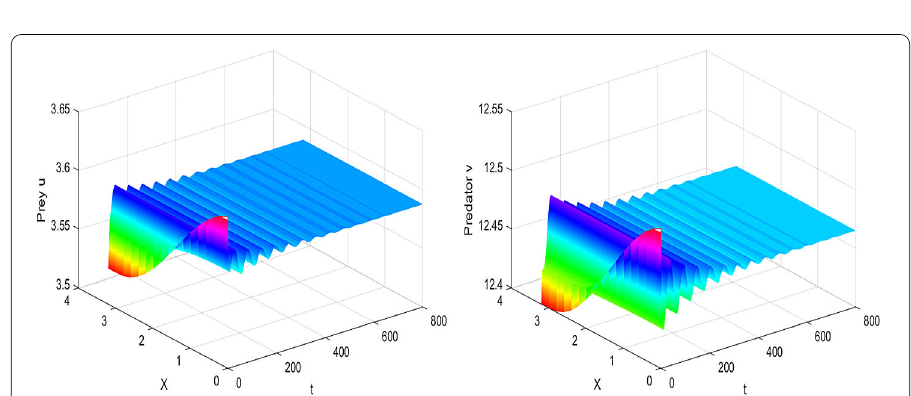
Figure 3 The coexisting equilibrium E ∗ is locally stable where τ = 3 < τ 0